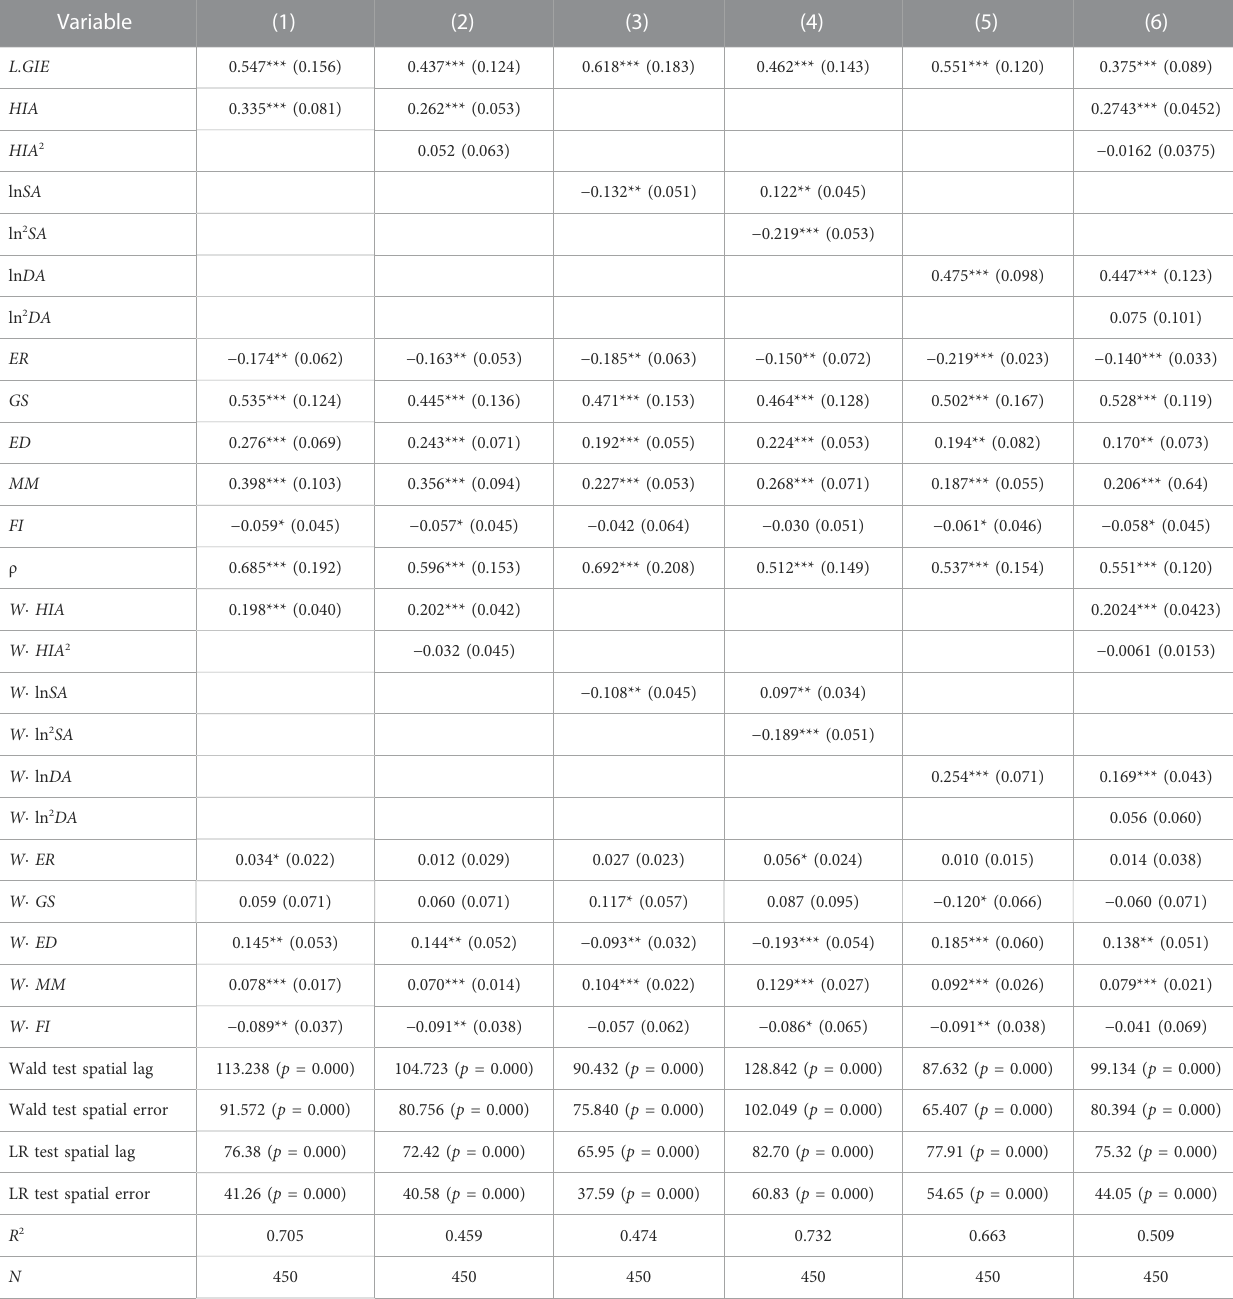
TABLE 5 Dynamic spatial Durbin model estimation